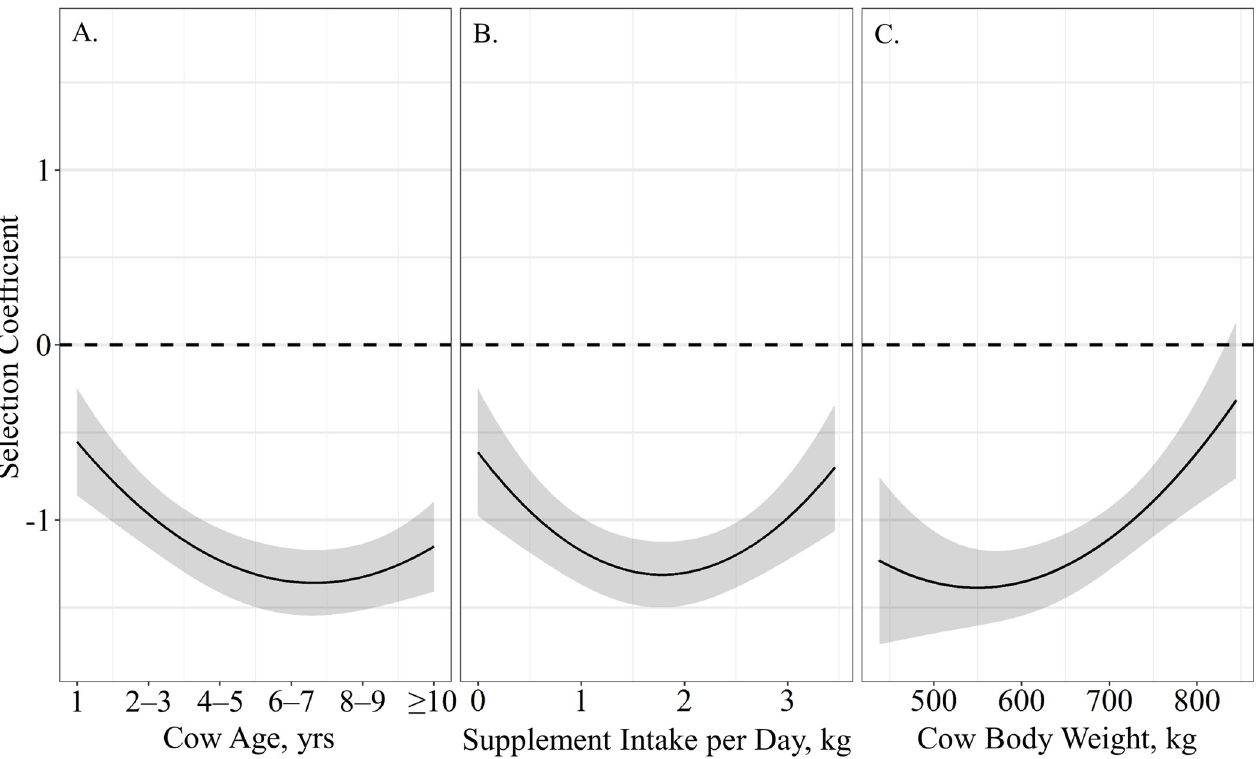
Fig 4. Predicted relationships ( ± 95%CI represented in the shaded area) between ( A ) cow age (years), ( B ) average supplement intake per day (kg) and ( C ) cow body weight (kg) on resource utilization relative to distance from supplement by cattle grazing dormant northern mixed grass rangeland in 2016 – 2017 & 2017 – 2018 at the Northern Agricultural Research Center Thackeray ranch, Havre,